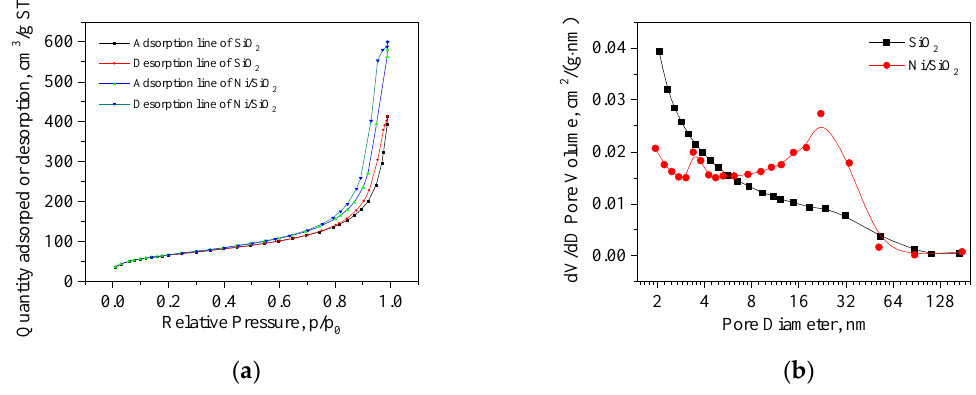
Table 1. Textural properties of the support and catalyst.